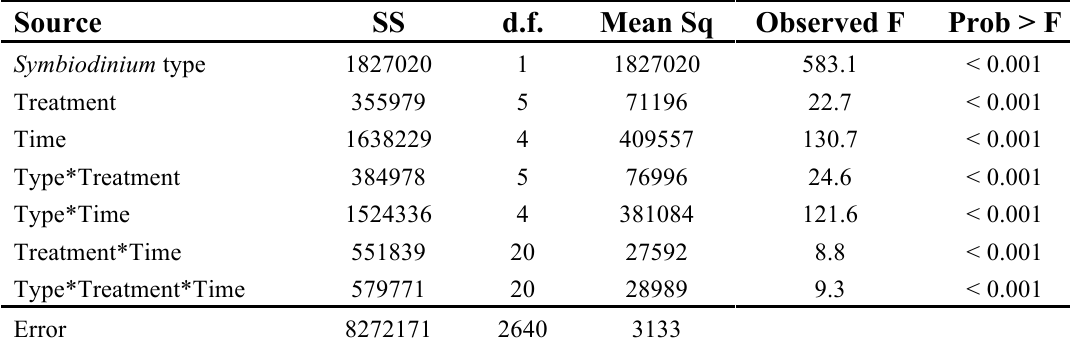
Table 1. Three-factor orthogonal ANOVA comparing the mean abundance of Symbiodinium cells in larvae of Acropora tenuis between symbiont types (C1 and D), among cell surface treatments (two enzymes, three lectins and unmodified controls) and sampling times (12, 24, 48, 72 and 96 h).